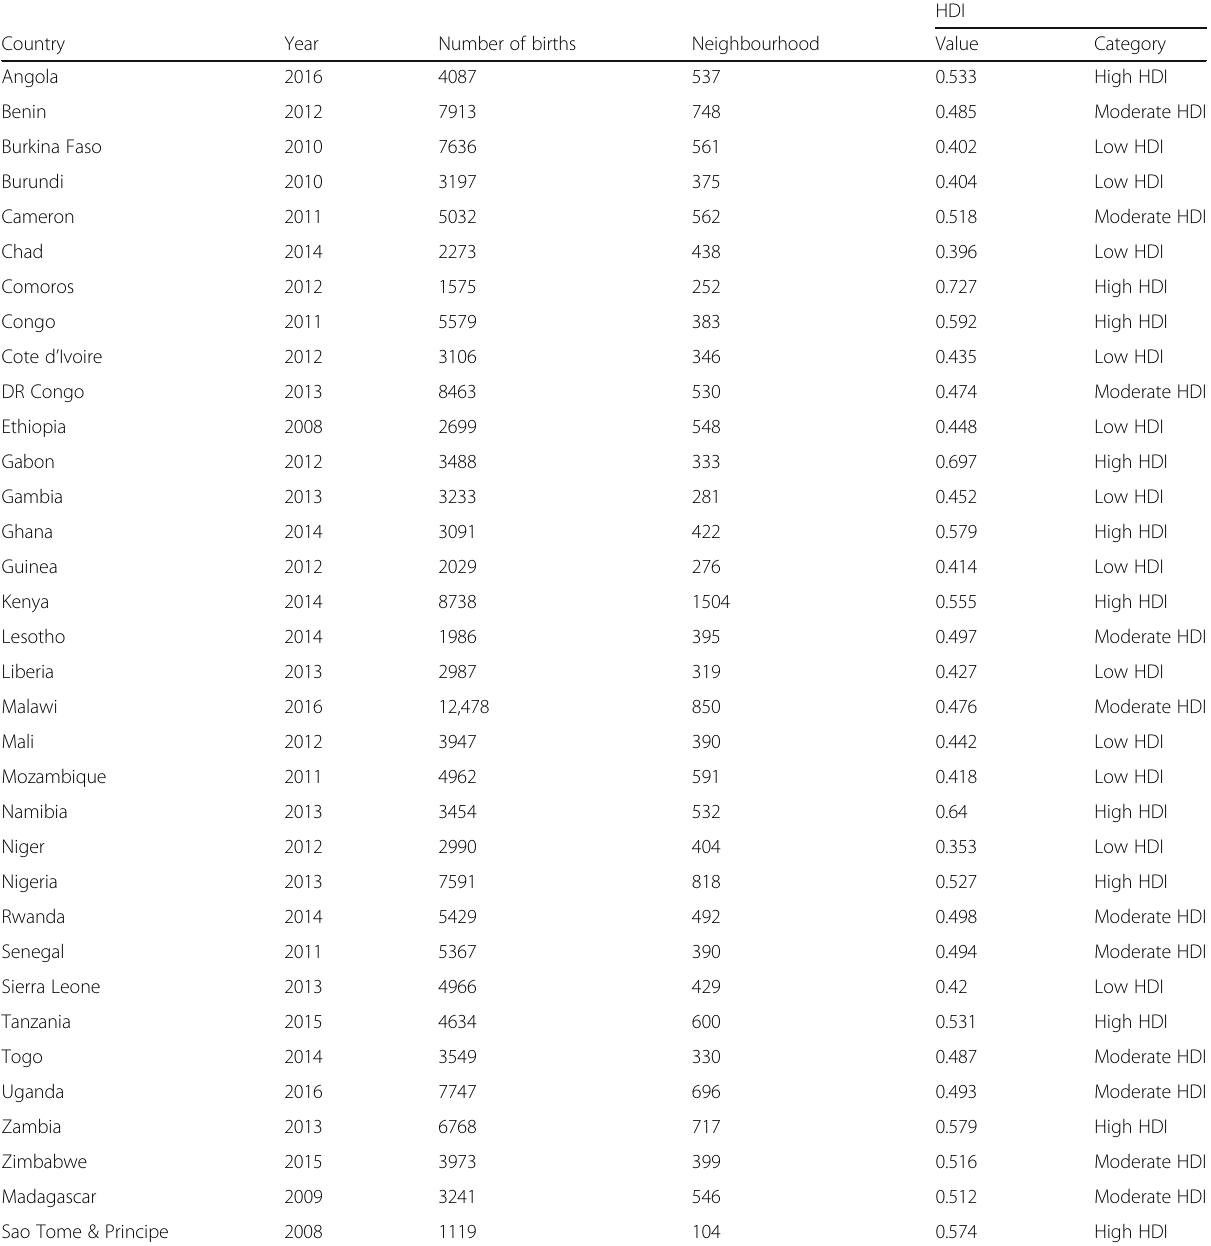
Table 1 Description of Demographic and Health Surveys data by countries, in sub-Saharan Africa, 2007 to 2016